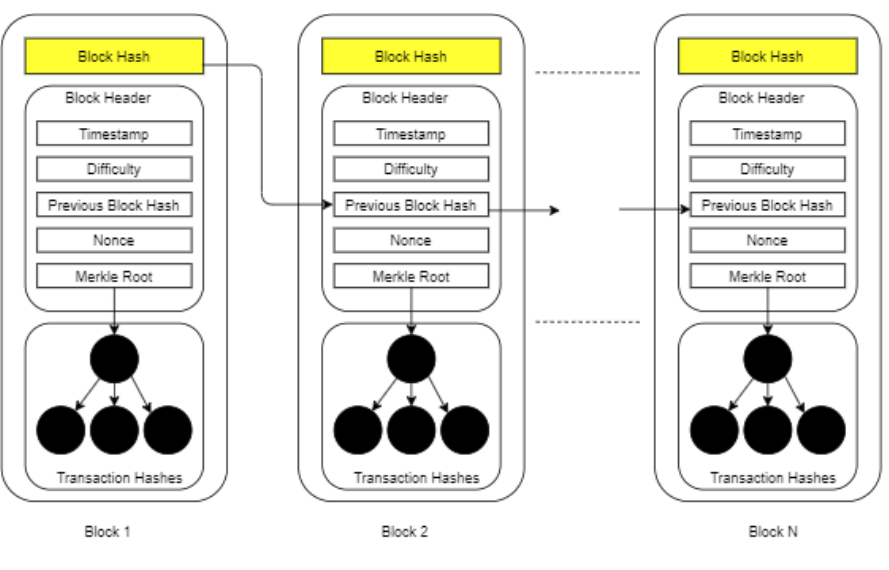
Figure 1. Structure of